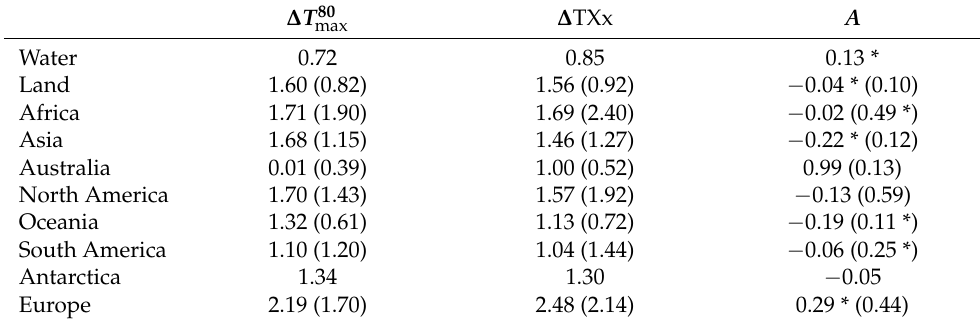
Table 1. Smoothed change in T 80 max , TXx, and in their difference (amplification A ) over 1959–2021 in ERA5 by water/land and continent. ∆ ∆ T 80 max